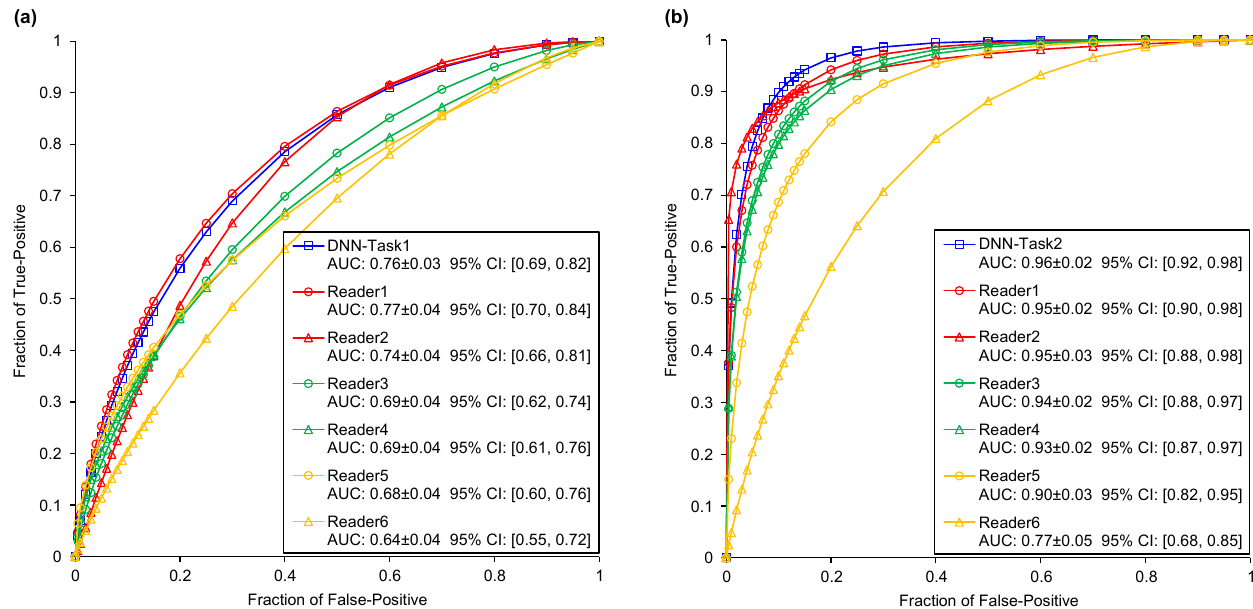
Figure 3. Comparisons of ROC curves and AUC values generated by DNN model and six readers (Table 2). ( a ) The Task1 ROC curves of DNN model and six readers. ( b ) The Task2 ROC curves of DNN model and six readers.